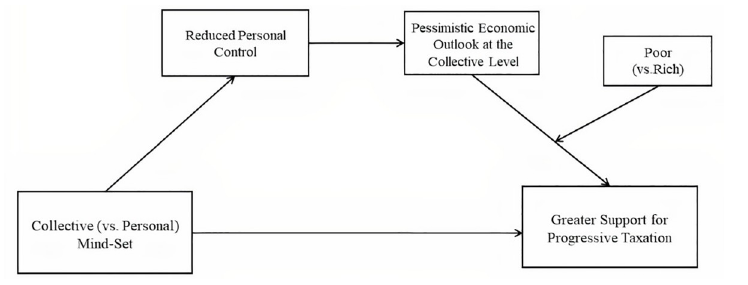
Fig 1. Key paths of the working